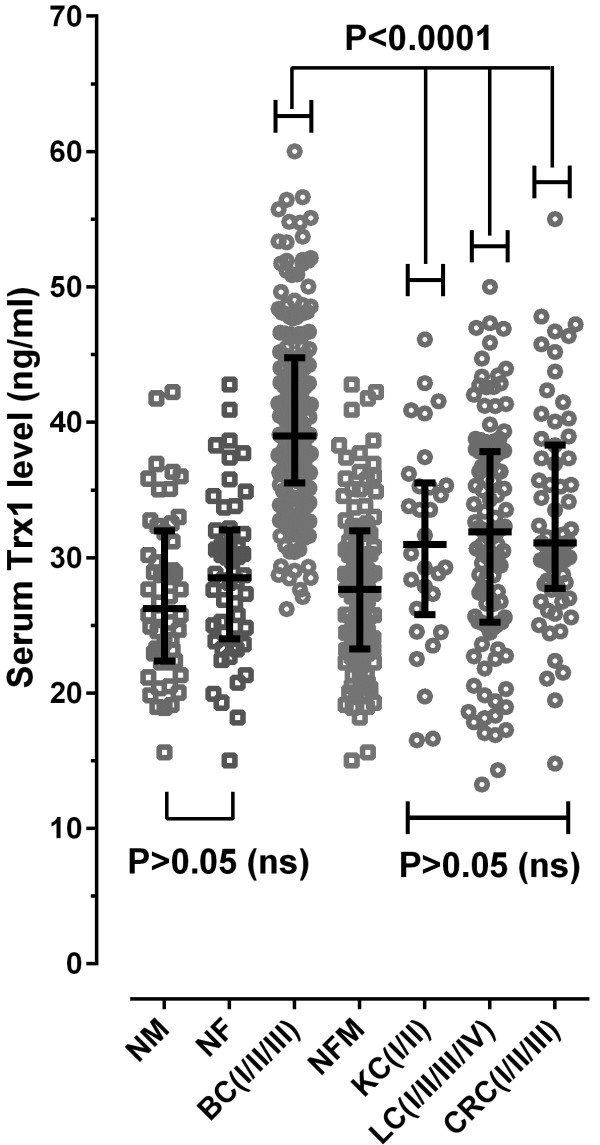
Serum Trx1 levels in the breast cancer group and other cancer groups (kidney cancer, lung cancer and colorectal cancer). Clinicopathological information for each patient was provided by the supplier. The individual mean value (n = 3) was depicted as a scatter plot. The median value of each group is depicted by horizontal lines, and the interquartile range is displayed by vertical lines extending to the up and down of the median. Abbreviations: BC, breast cancer; KC, kidney cancer; LC, lung cancer; CRC, colorectal cancer; NM, male normal control; NF, female normal control; NFM, female and male normal controls.